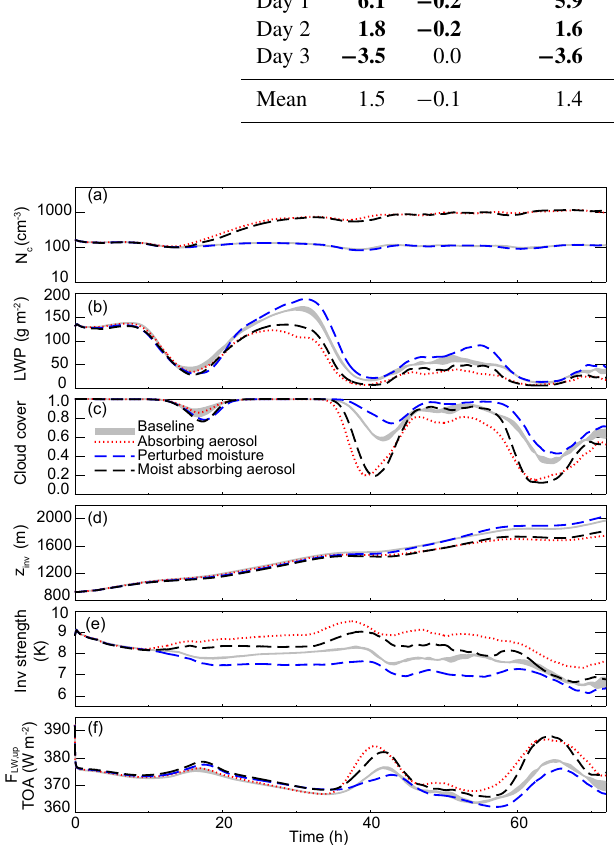
Figure 9. As in Fig. 2. Range of the three-member lightly drizzling baseline ensemble ( N a , sulfate = 150mg − 1 ) shown in gray. Results with an absorbing aerosol layer shown as red dotted line. Baseline with moist layer aloft shown as blue dashed line. Results with moist absorbing aerosol shown as black dashed